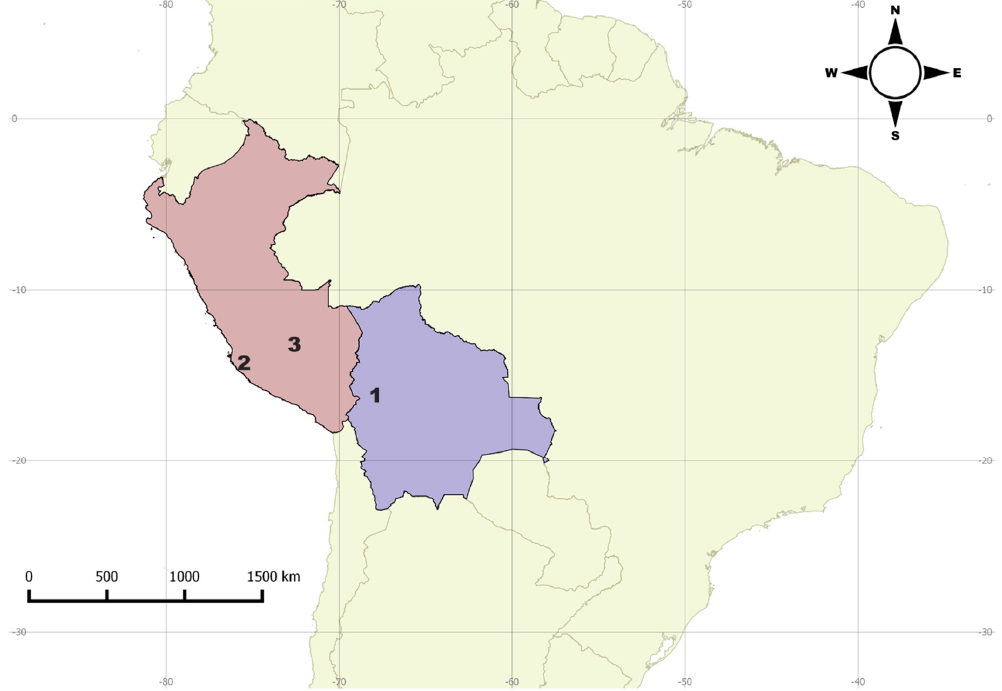
Figure 12. Distribution map for Mycotretus prioteloides Mader, 1942. Bolivia: 1—Coroico. Peru: 2—Calango; 3—Machu Picchu. Diagnosis. Pronotal edges black, with a shallow and transverse black mark at posterior or anterior edges; pronotal portion with two transverse or subcircular black spots on the disc. Outer edges of pronotum and mesal sutural edge of elytra with black outline. Elytral coloration with several black, subcircular and transverse free spots. Penile flagellum well-developed and slightly elongated, approximately 0.8 × the length of penis, slightly sinuous, with a membranous portion between its virga and head. Head of flagellum sclerotized, slightly elongated and, unlike in M. tigrinus , conspicuously convex anteriorly; inner outline somewhat more separated than in M. tigrinus . Redescription . Length (in mm) = 5.75–7 (6.29 ± 0.63, n = 3). Body elongate, widest at anterior third of elytra, TL/EW = 1.75–1.91 (1.83 ± 0.08) (measurements based on examined specimen and in Mader’s original description based on holotype and one paratype), glabrous and glossy, dorsal and ventral coloration homogeneously yellowish or reddish-brown (Figure 11A and 11C,D). Mouthparts reddish-brown with outer contour of last maxillary and labial palpomeres yellowish; mentum plate pentagonal, with strongly sclerotized margin; mandible apices and antennomeres 2–11 blackish (scape reddish-brown). Trochanters, apical portion of femora, tibiae and dorsum of tarsi blackish; tarsi (ventrally) and claws yellowish to reddish-brown. Elytral epipleuron partially black and yellowish (Figure 11D, arrows). Scutellar shield blackish, glabrous and bearing few punctures. Dorsal coloration: head without spots; pronotal edges black, with a shallow and transverse black mark on the anterior (Figure 11A, arrow) and posterior edge (Figure 11C, arrow); disc of pronotum with two transverse (Figure 11A) or subcircular (Figure 11C) black spots. Outer edges of pronotum and mesal sutural edge of elytra with black outline. Elytral coloration with several black, subcircular and transverse free spots. Male terminalia. (Figure 11E–G). Penis (Figure 11E, pen) slightly elongated and curved; basal portion with short sclerotized projection linked to apophyses; internal sac with well-developed and slightly elongated flagellum (Figure 11E, fla), 0.8 × the length of penis ( n = 1), slightly sinuous, with a membranous portion between the virga and head (Figure 11F, arrow). Head of flagellum (Figure